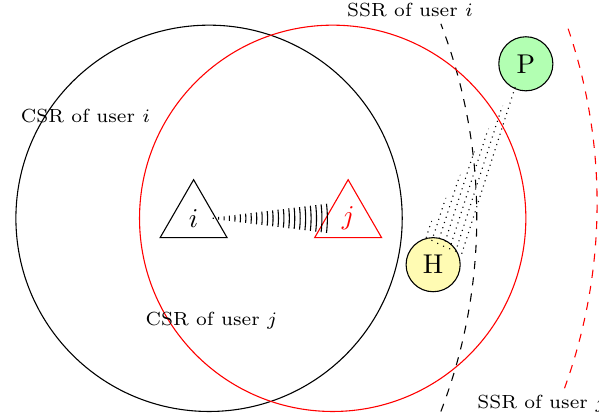
Figure 2. Example scenario of the hidden primary terminal problem. CSR, Carrier Sensing Range; SSR, Spectrum Sensing Range; P, Primary Terminal; H, Hidden Primary